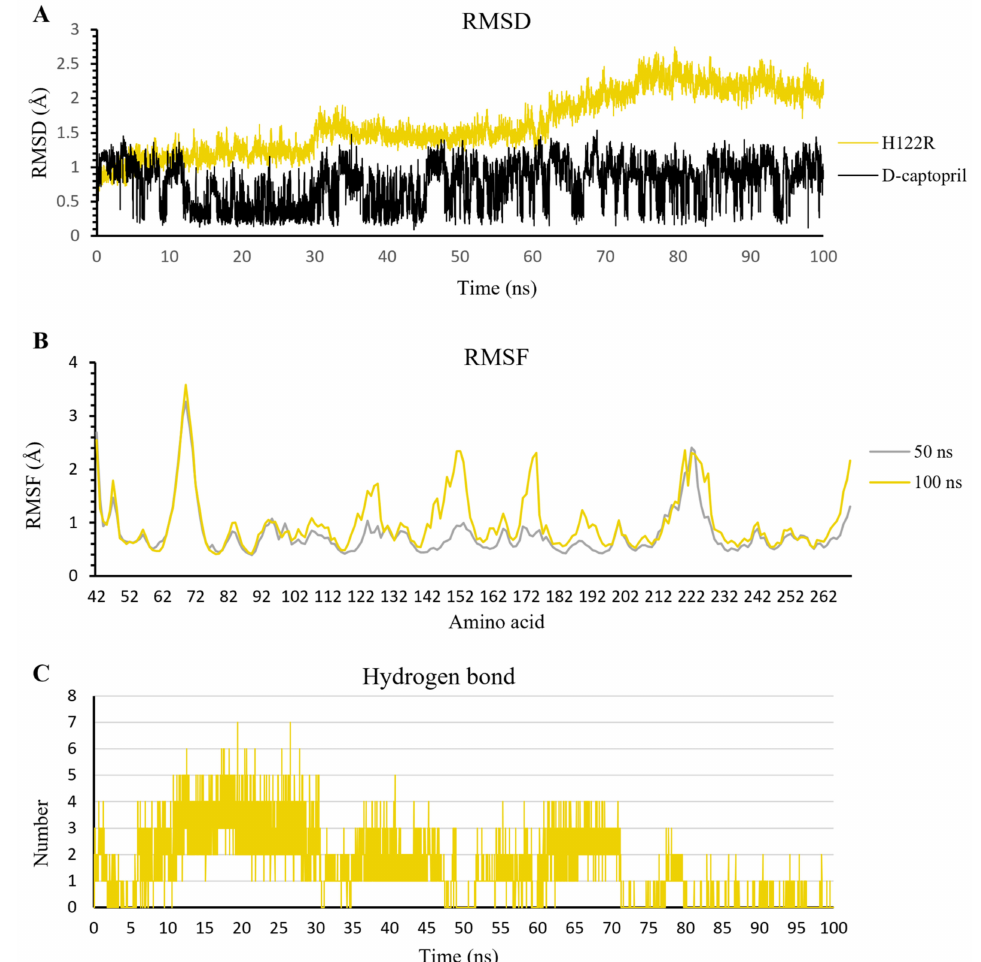
Figure 10. The result of d-captopril/H122R complex in 100 ns simulation time. ( A ) The RMSD value of H122R protein and d-captopril. ( B ) The RMSF value of 50 ns and 100 ns simulation time. ( C ) The average number of H-bonds formed by d-captopril with H122R mutant protein during MD